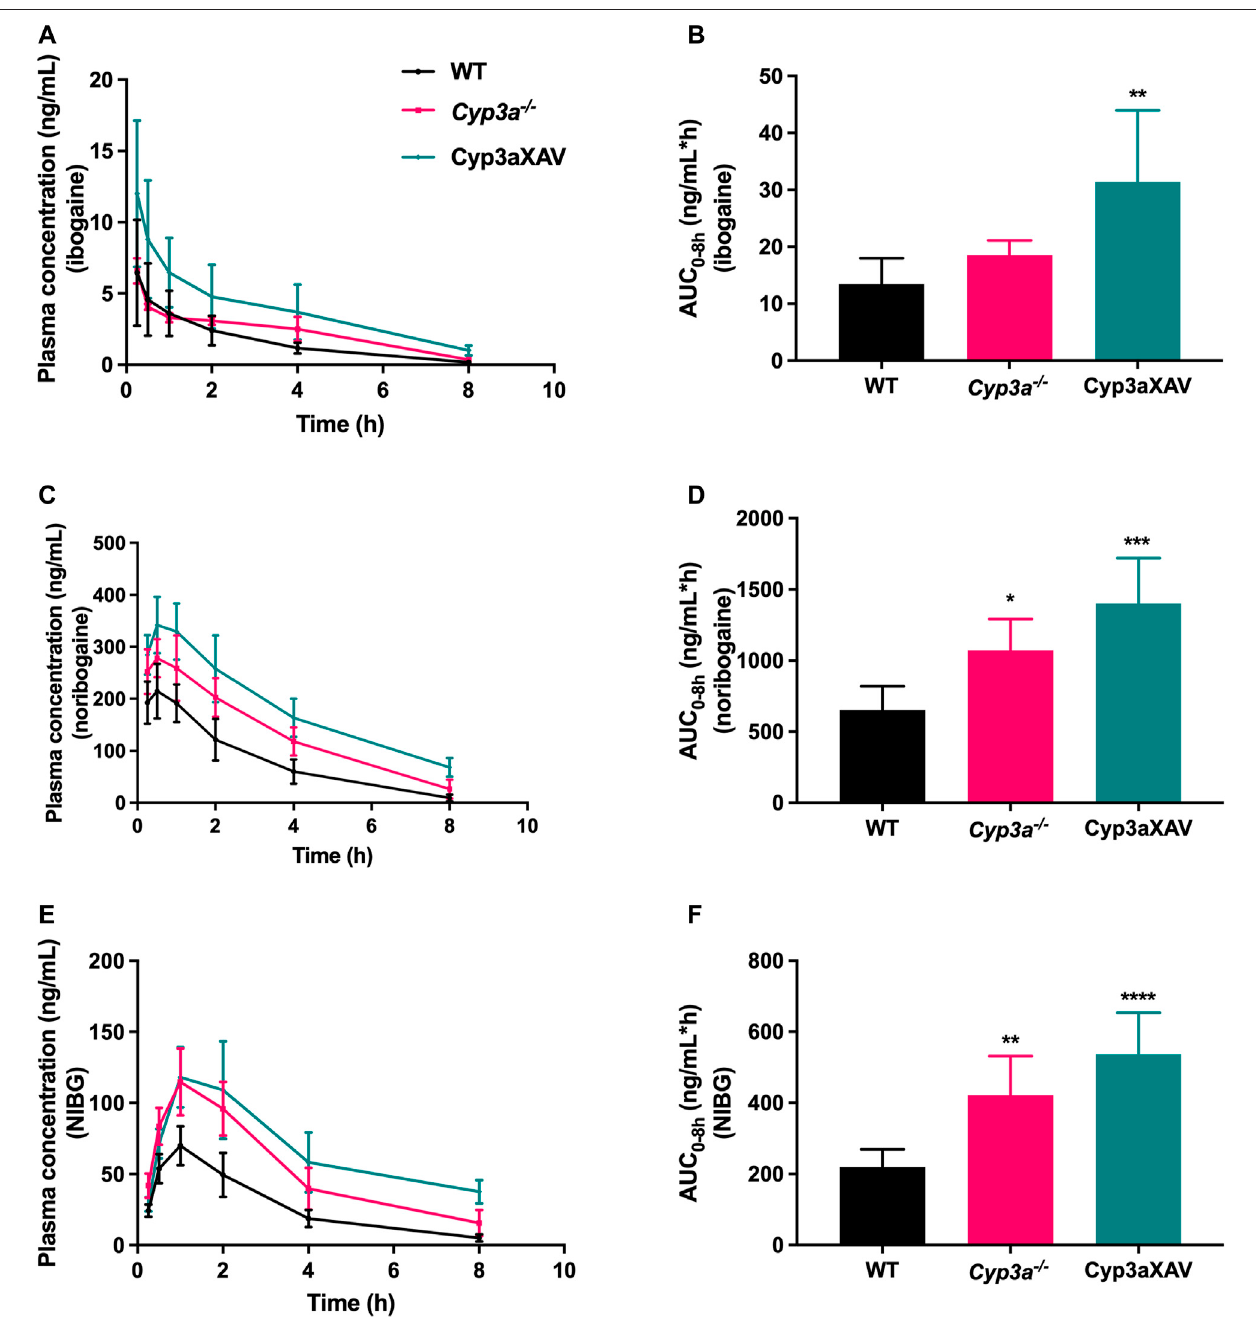
FIGURE 5 | Plasma concentration-time curves (A,C,E) and plasma AUCs (AUC 0 – 8h ) (B,D,F) of ibogaine, noribogaine, and noribogaine glucuronide (NIBG) in femalewild-type(WT),Cyp3aknockout( Cyp3a − / − ),and Cyp3a − / − micewithspeci fi ctransgenicexpression ofhumanCYP3A4inliverandintestine(Cyp3aXAV),over 8 h after oral administration of 10 mg/kg ibogaine ( n = 4 – 6). Data are presented as mean ± SD. *, p < 0.05; **, p < 0.01; ***, p < 0.001; ****, p < 0.0001 compared to wild- type